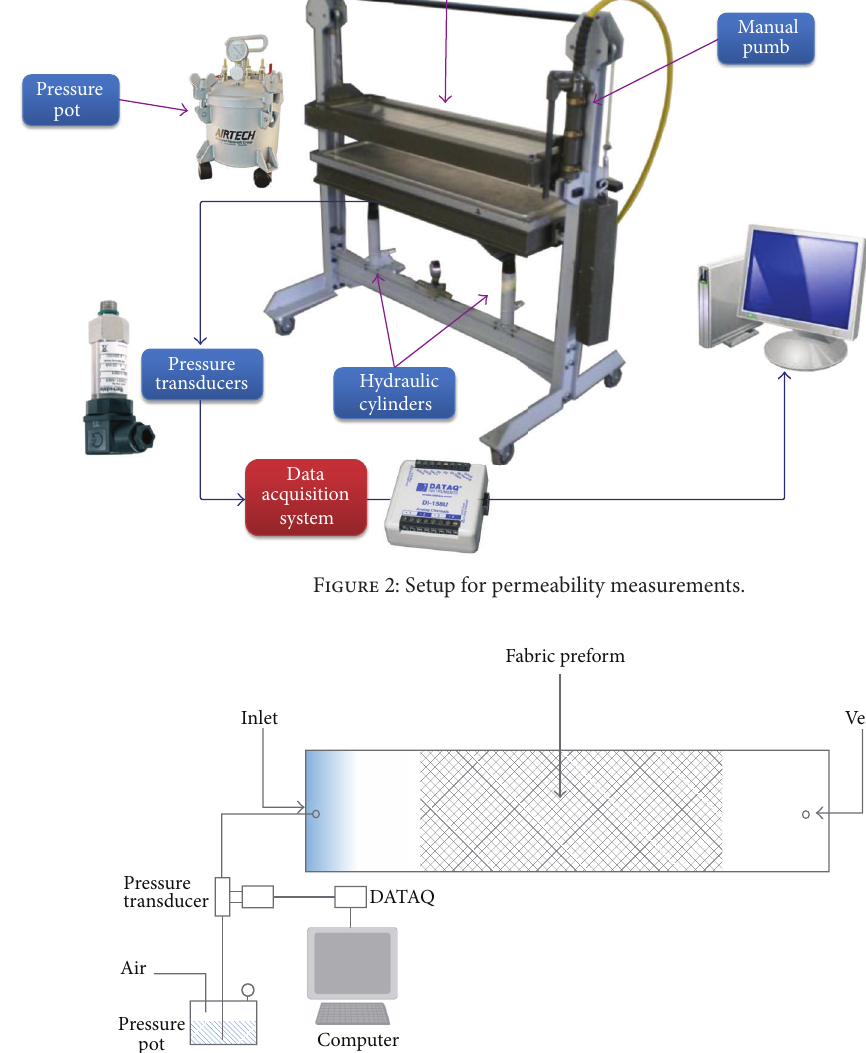
Figure 3: Schematic representation of the experimental